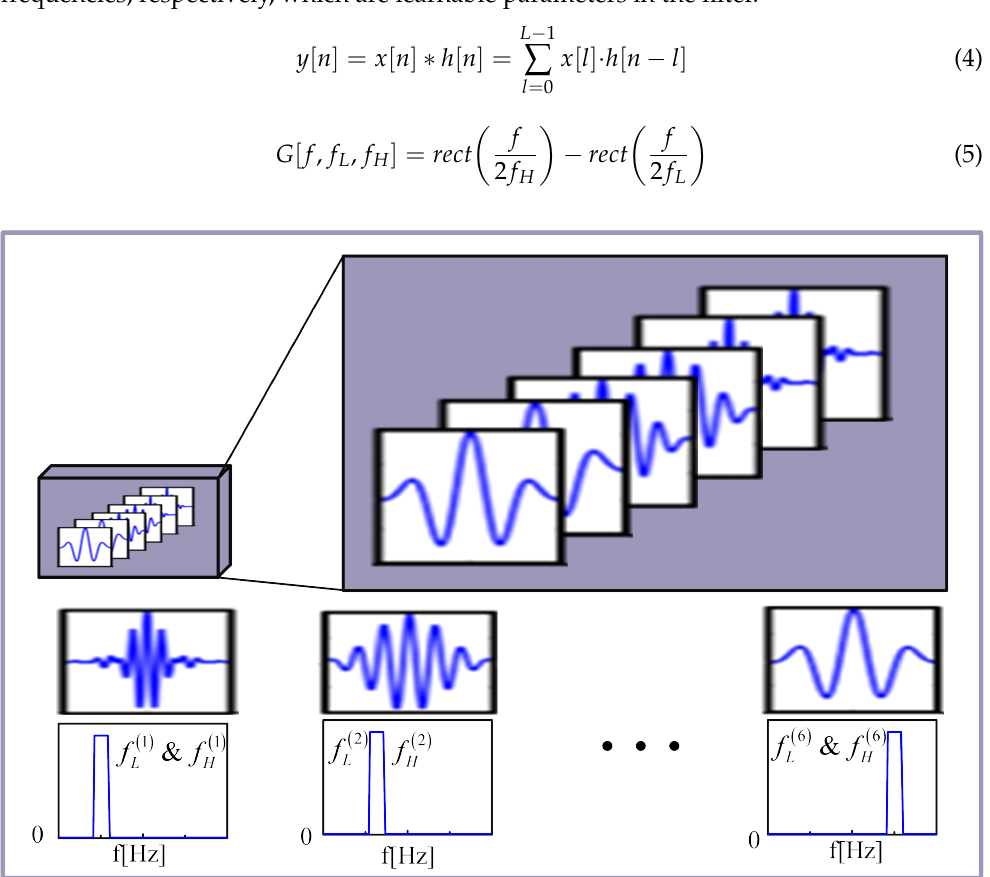
Figure 3. The internal structure of Sinc